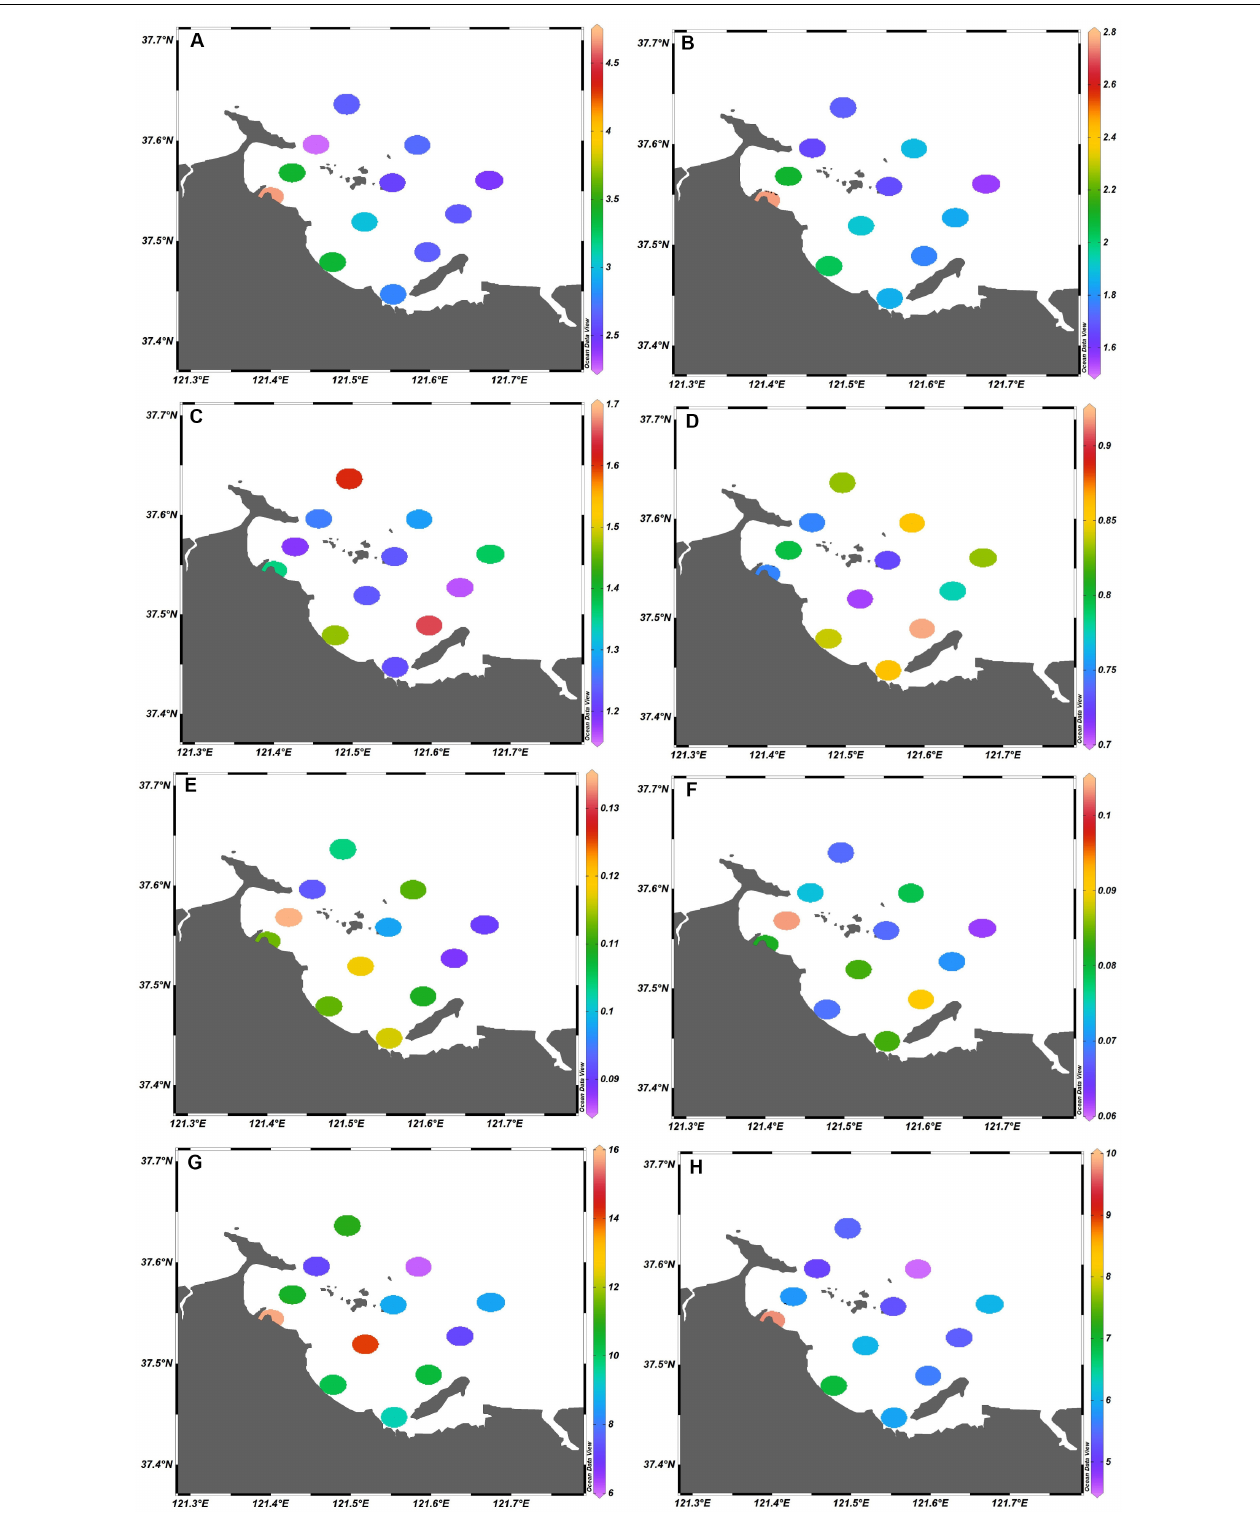
FIGURE 5 | Spatial distribution of the concentrations of total dissolved and dissolved reactive TMs (annual average values) in the surface seawater of Sishili Bay. (A) Total dissolved Cu ( µ g/L), (B) dissolved reactive Cu ( µ g/L), (C) total dissolved Pb ( µ g/L), (D) dissolved reactive Pb ( µ g/L), (E) total dissolved Cd ( µ g/L), (F) dissolved reactive Cd ( µ g/L), (G) total dissolved Zn ( µ g/L), and (H) dissolved reactive Zn ( µ g/L).